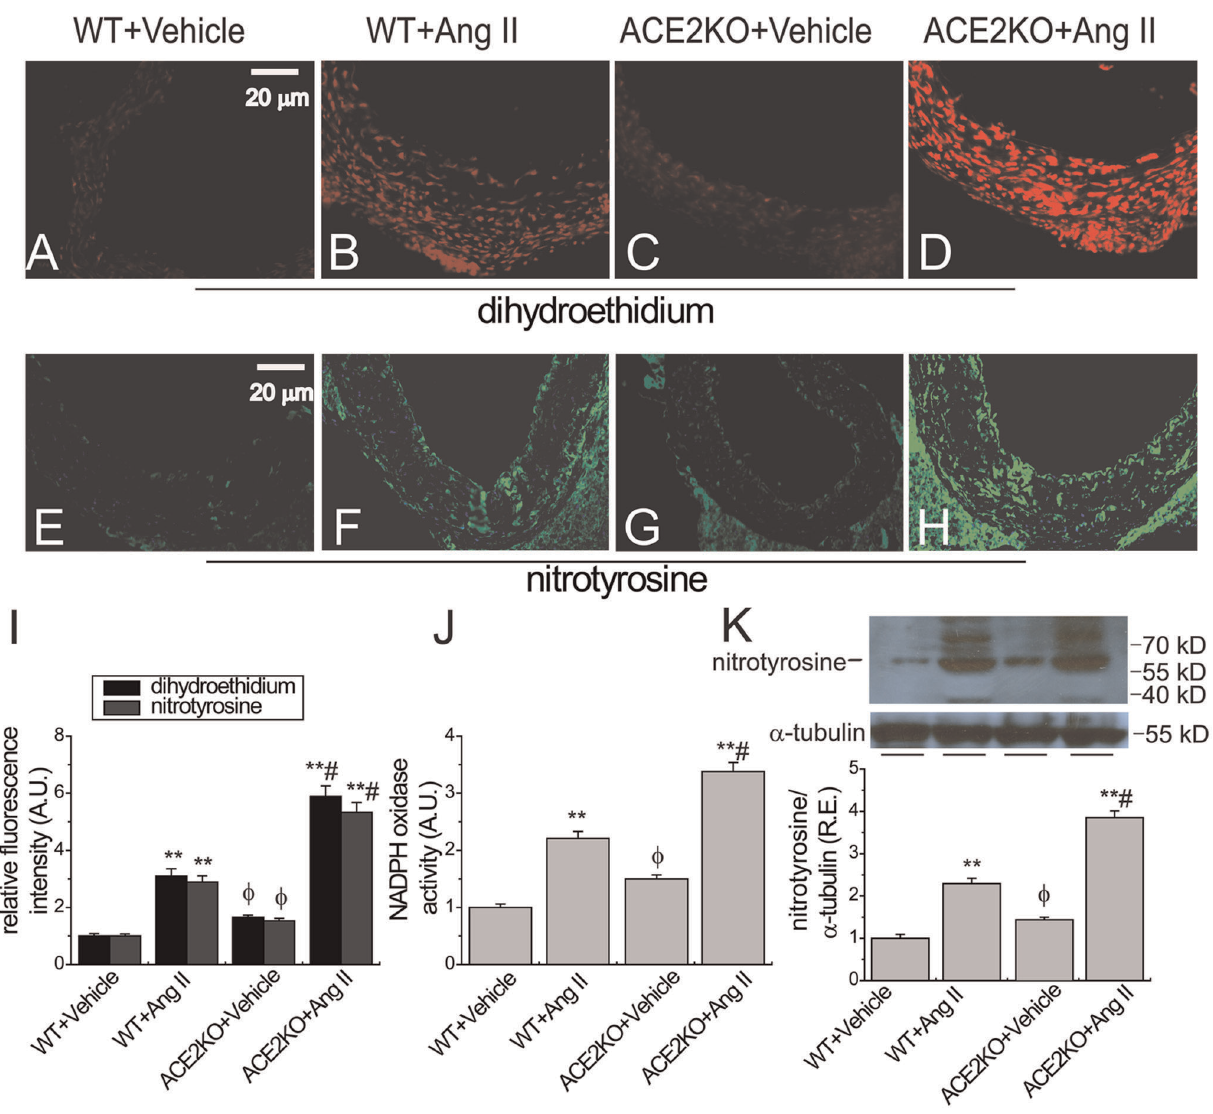
Figure 3. Ang II-mediated aortic superoxide and peroxynitrite generation in ACE2KO mice. Representative dihydroethidium (A–D) and nitrotyrosine (E–H) fluorescence images, relative fluorescence values (I) and NADPH oxidase activity (J) exhibited aortic superoxide generation and nitrotyrosine formation and NADPH oxidase activities in WT and ACE2KO mice in response to Ang II. Representative Western blot analysis showed protein level of nitrotyrosine (K; 60 kD) in aortas of WT and ACE2KO mice infused with Ang II. R.E.=relative expression; KO, knockout; A.U., arbitrary units; NADPH, nicotinamide adenine dinucleotide phosphate; a -tubulin (55 Kd) was used as an endogenous control. n=5 2 6. ** P , 0.01 compared with corresponding vehicle-treated group; # , P , 0.05 compared with WT + Ang II group; w , P , 0.05 compared with WT + Vehicle